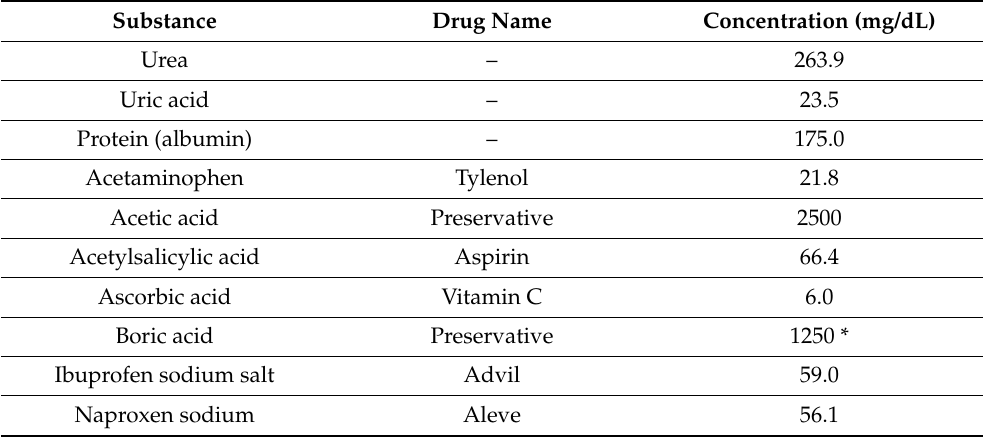
Table 3. Results of interference testing showing highest concentration of substance tested that did not interfere with citrate or creatinine assay results. Substance Drug Name Concentration